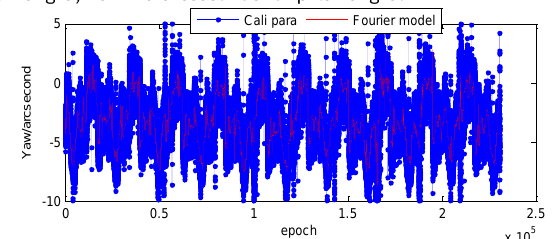
Figure 4. Chart of conversion parameters variation in yaw direction between AB and BC